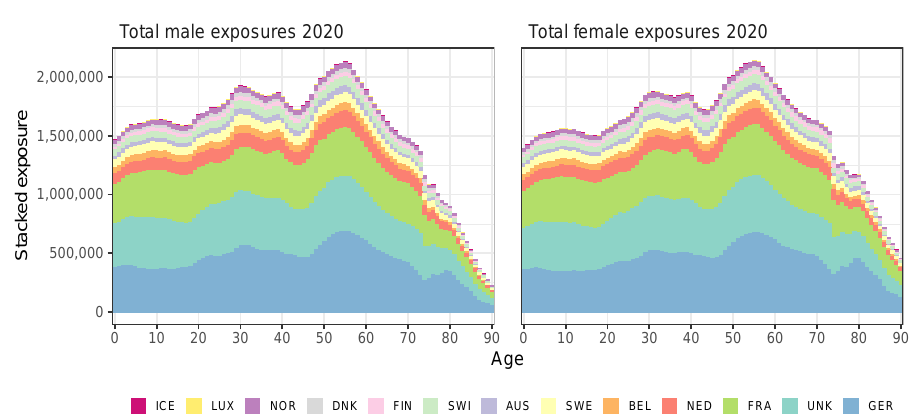
Figure 2. Stacked male ( left ) and female ( right ) exposure for the combined thirteen European countries in 2020 as a function of age. Exposures for the year 2020 are directly available from the HMD for Denmark. However, for Germany, United Kingdom, France, Netherlands, Belgium, Sweden, Austria, Switzerland, Finland, Norway, Luxembourg and Iceland, we transform the weekly exposures collected in age buckets from the STMF data series to exposures at individual ages for the year 2020.